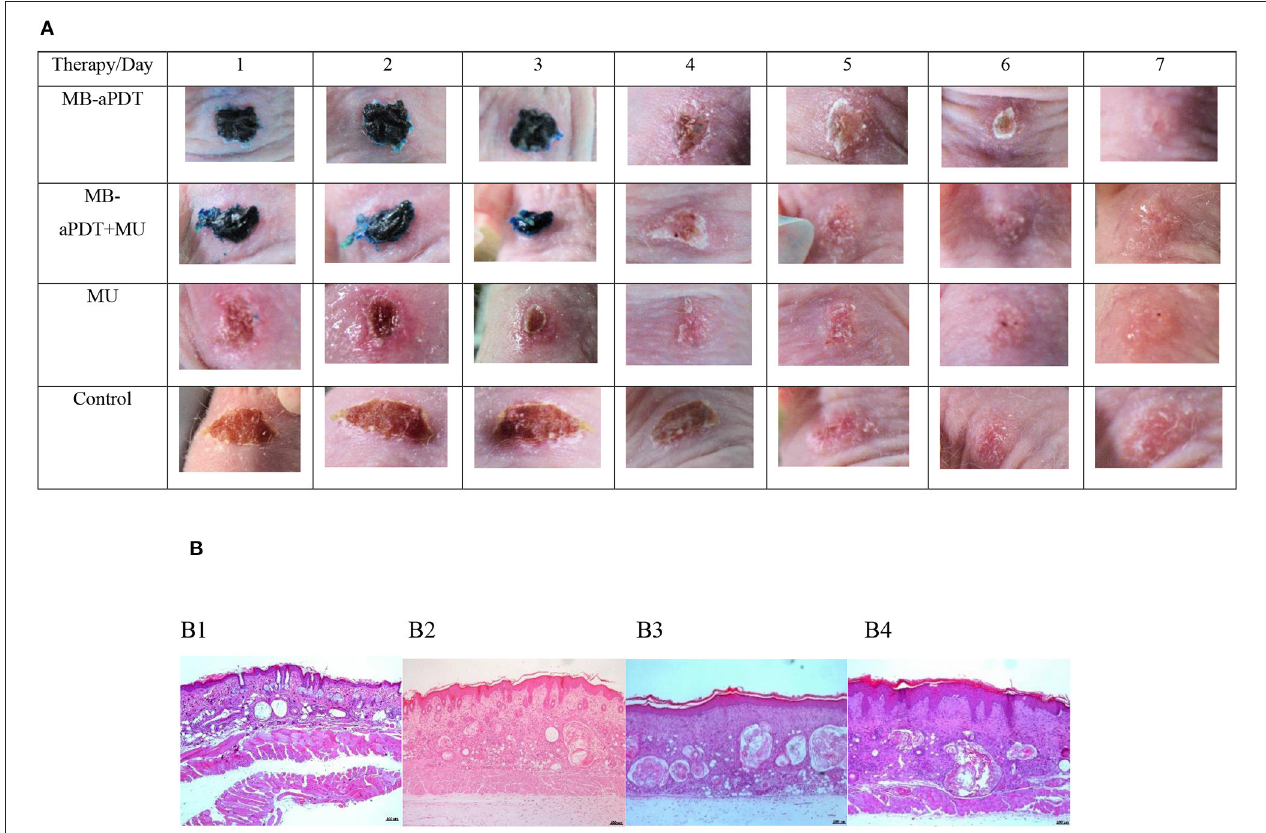
FIGURE 3 | Comparison of photographs (A) /microphotographs (B) . (A) Clinical evolution of wounds infected by S. aureus during 7 days on therapeutical challenge and (B) healthy skin and infected wounds in function of therapy. (A) Photographs. (B) Microphotographs. From the left to the right of the image. (B1) Normal skin showing the mild undulation of the epidermis, thin dermis, dilated empty follicles typically observed in nude mice, and the muscle layer. H-E. x50. (B2) aPDT-treated wound. Note the mild acanthosis and mild undulation of the epidermis, a thicker dermis with moderate dermal fibrosis and more dilated follicles with abundant keratin and granulomatous inflammation. H-E. x50. (B3) aPDT + MU-treated wound. Epidermis shows slightly more acanthosis and orthokeratotic hyperkeratosis, slightly more cellularity in the dermis and more follicular reaction than aPDTtreated wounds. H-E. x50. (B4). MU-treated wound. Note intense acanthosis with abundant rete pegs and orthokeratotic hyperkeratosis, a slightly thinner dermis and a marked follicular reaction. H-E.